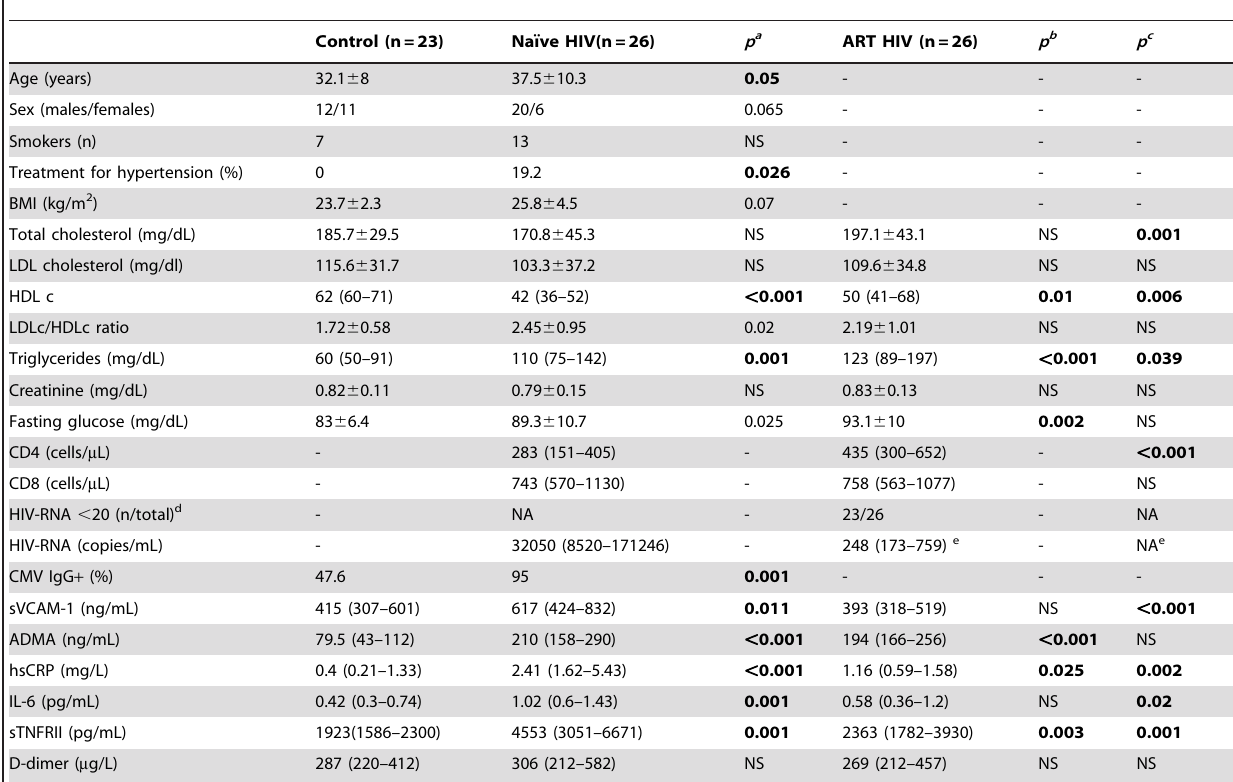
BMI= Body mass index. CMV=cytomegalovirus, NS= Not significant. NA= Not applicable. a) p for control subjects vs. naive HIV patients. b) p for control subjects vs. HIV patients with 48 weeks of ART. c) p for comparison of HIV patients at baseline vs. 48 weeks. d) Proportion of HIV patients with undetectable viral load at 48 weeks. e) Values calculated using the only 3 patients with detectable viral loads at 48 weeks (with descriptive aims, no comparison).